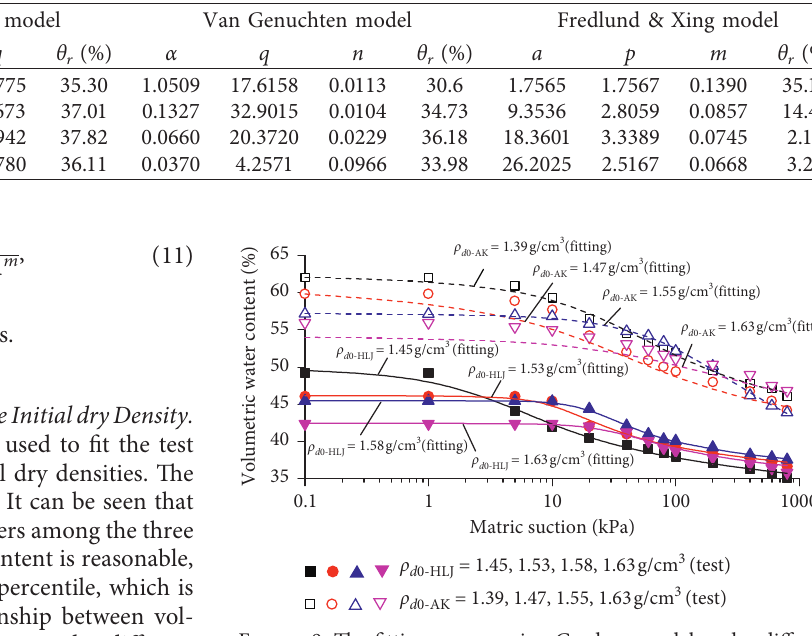
Table 2: Fitting parameters of SWCC with different initial dry densities of HLJ soil.